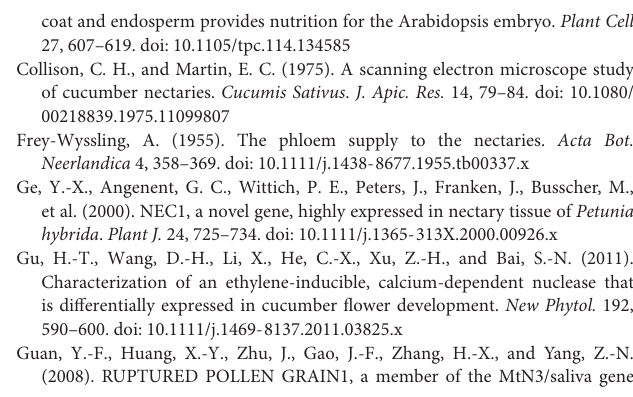
Supplementary Figure 1 | Expression patterns of the SWEET gene family in cucumber flowers. (A) The expression pattern of the cucumber SWEET gene family in male (MF) and female flowers (FF). Data used in panel (A) came from RNA-seq data (PRJNA80169) in the cucumber database. (B) The relative expression level of CsSWEET7a from stage 9 to anthesis in male flowers. Mean values ± SE of three independent biological replicates were given. RPKM, Reads Per Kilobase per Million mapped reads. Supplementary Figure 2 | Expression pattern of genes coding for sugar metabolism-related enzymes in cucumber. Relative expression pattern of AGA1 (A) , SUS4 (B) , CINV1 (C) , and CWINV4 (D) in root, stem, leaf, male flower, female flower, and ovary at anthesis. AGA1 (Csa4G631570), alkaline a-galactosidase 1 ; SUS4 (Csa5G322500), sucrose synthase 4 ; CINV1 (Csa5G615240), cytosol invertase 1 ; CWINV4 (Csa2G351670), cell wall invertase 4 . Mean values ± SD of three replicates were shown. Statistical analyses were performed using one-way ANOVA followed by multiple comparisons using Fisher’s LSD method ( P -value < 0.05). Supplementary Figure 3 | Starch staining in nectary of male and female cucumber flowers. Different developmental stages of male (A–C) and female flowers (D–F) . (A,D) is 3 days before anthesis, (B,E) is 1 day before anthesis, and (C,F) is at the day of anthesis. The white arrows in panels (D–F) indicate nectary. DAA, days after anthesis; MF, male flower; FF, female flower; Nec, nectary. Supplementary Table 1 | Primers used in this